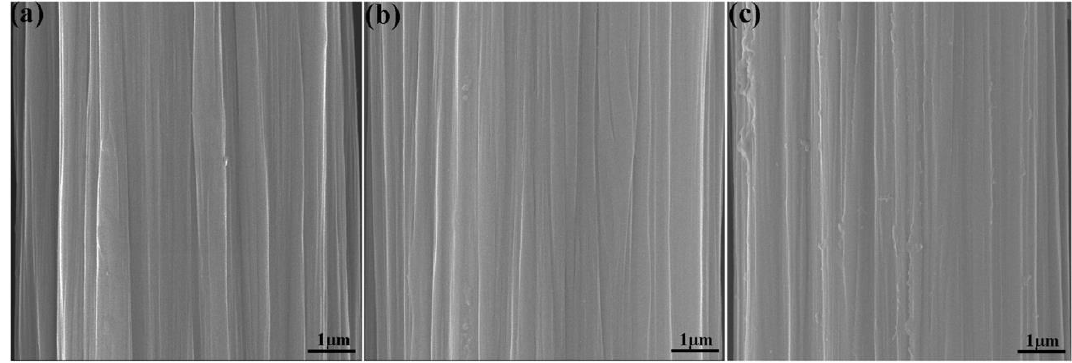
Figure 4. SEM images of di ff erent CF surfaces: ( a ) untreated CF, ( b ) CF-OH, and ( c ) CF-cardanol.